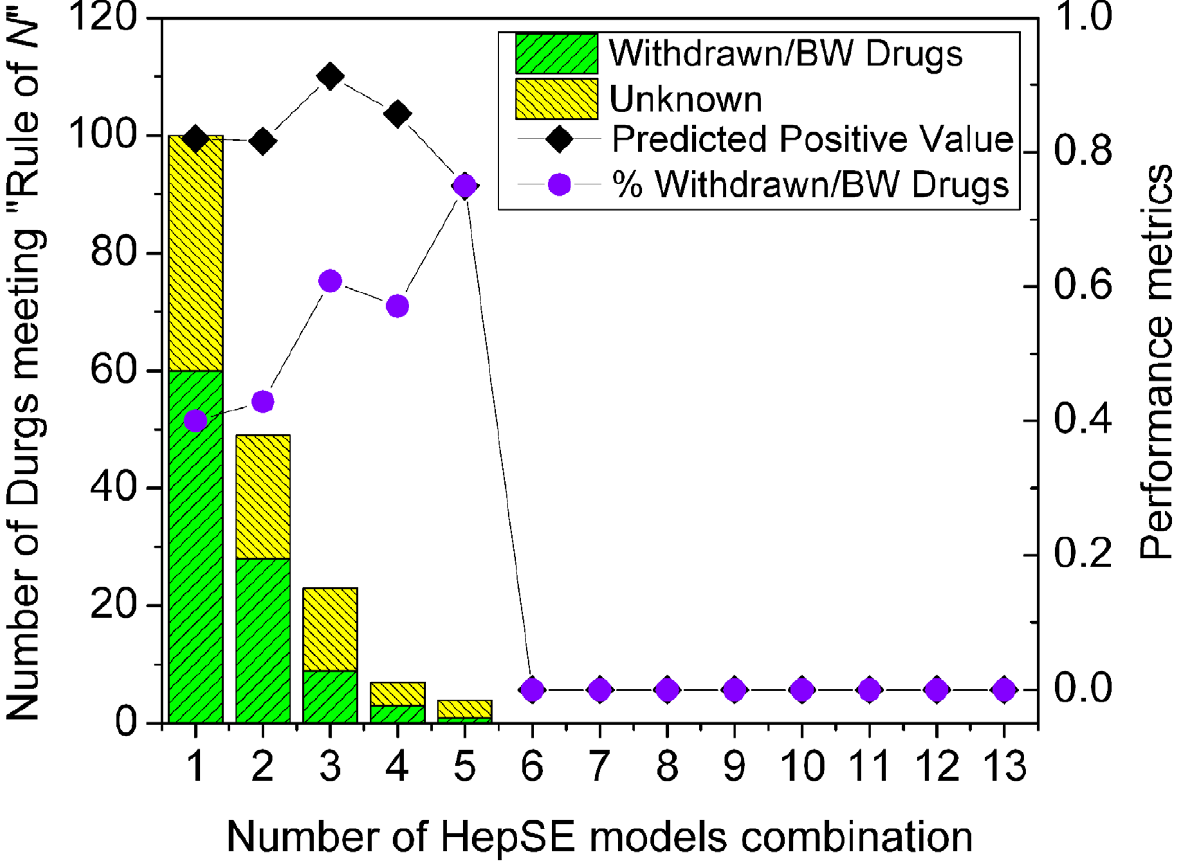
Figure 3. The evaluation of the ‘‘Rule of Three’’ (RO3). The predicted positive value, percentage of withdrawn or boxed warning (BW) drugs, and the number of drugs meeting the ‘‘Rule of N ’’ for different values of N in the combined HepSE model.